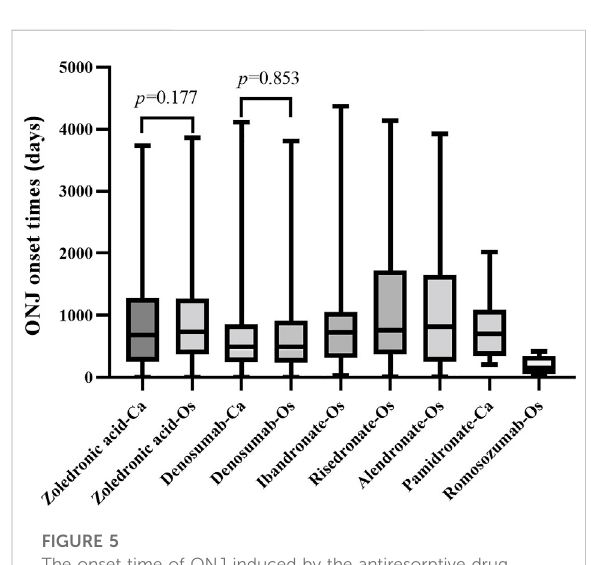
FIGURE 5 The onset time of ONJ induced by the antiresorptive drug with different indications. Abbreviation: ONJ, osteonecrosis of the jaw; Os, osteonecrosis-related indications; Ca, cancer-related